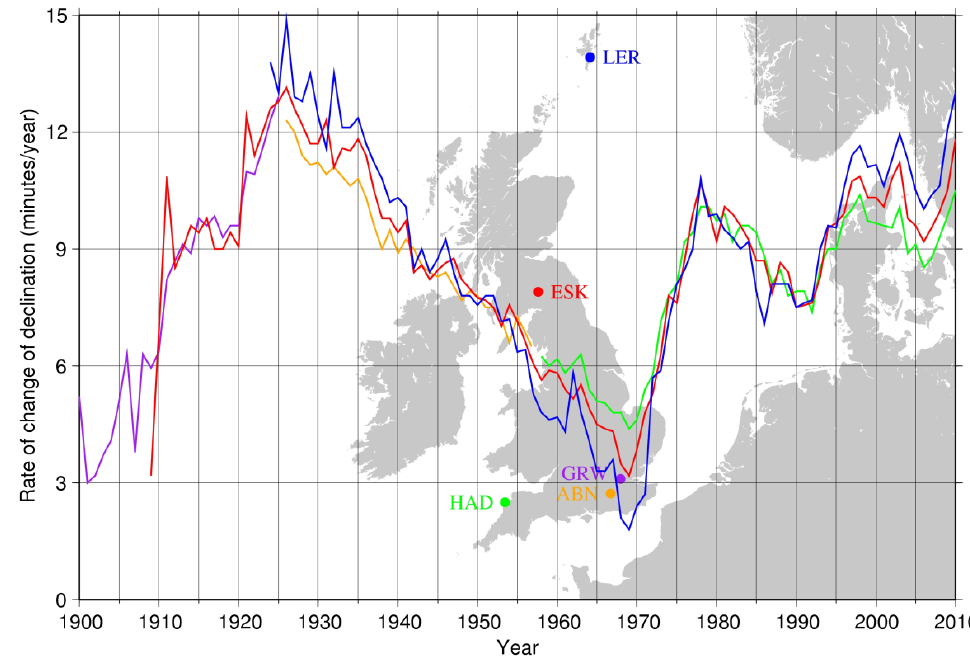
Figure 2. Change in secular variation (declination) from UK